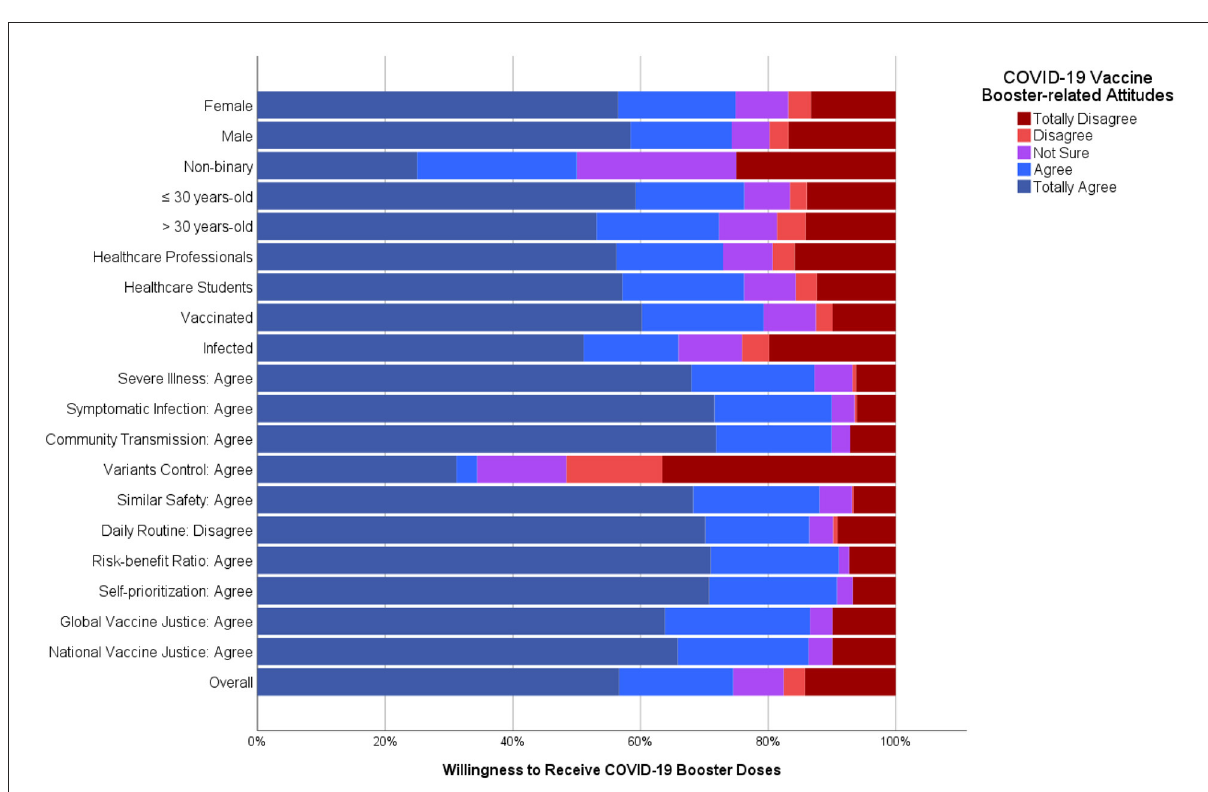
FIGURE1 Determinants of COVID-19 vaccine booster-related attitudes of polish healthcare professionals and students responding to COVID-19 VBH survey, December 2021–January 2022 ( n = 443).